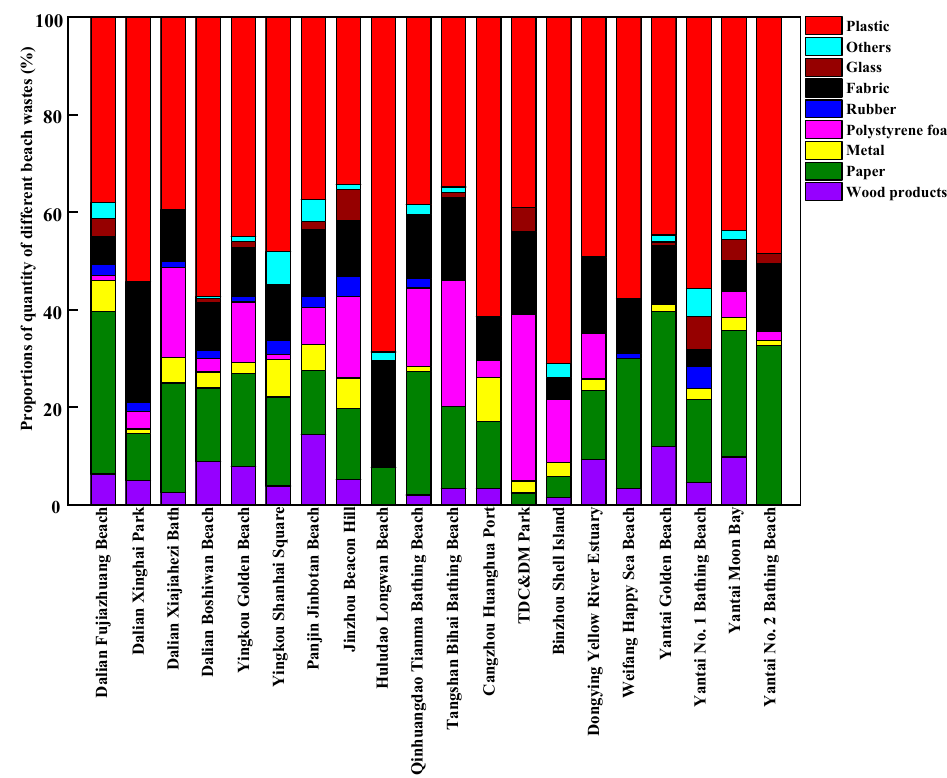
Figure 4. The proportions of different components of beach waste in coastal cities around the Bohai Sea of China in the tourist off-peak season, by weight.